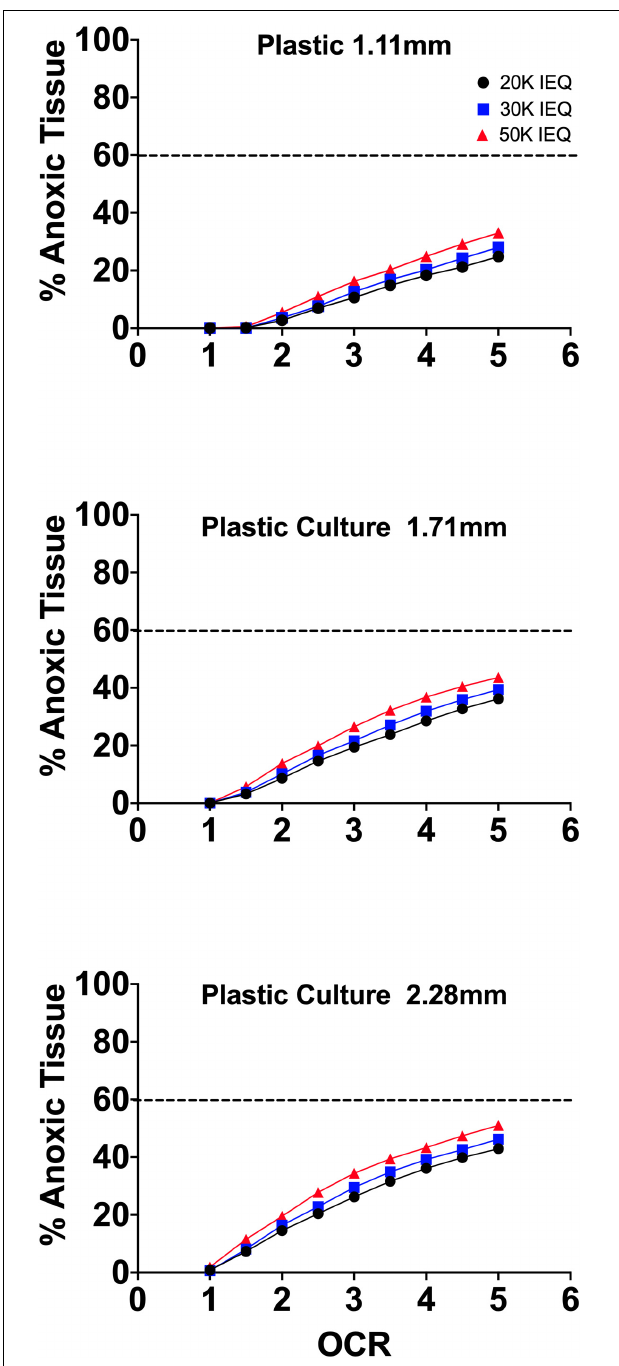
FIGURE 4 | FEM of standard islet culture on plastic with an external oxygen concentration of 35%. The modeled anoxia was ∼ 50–70% relative to culture at 20% O 2